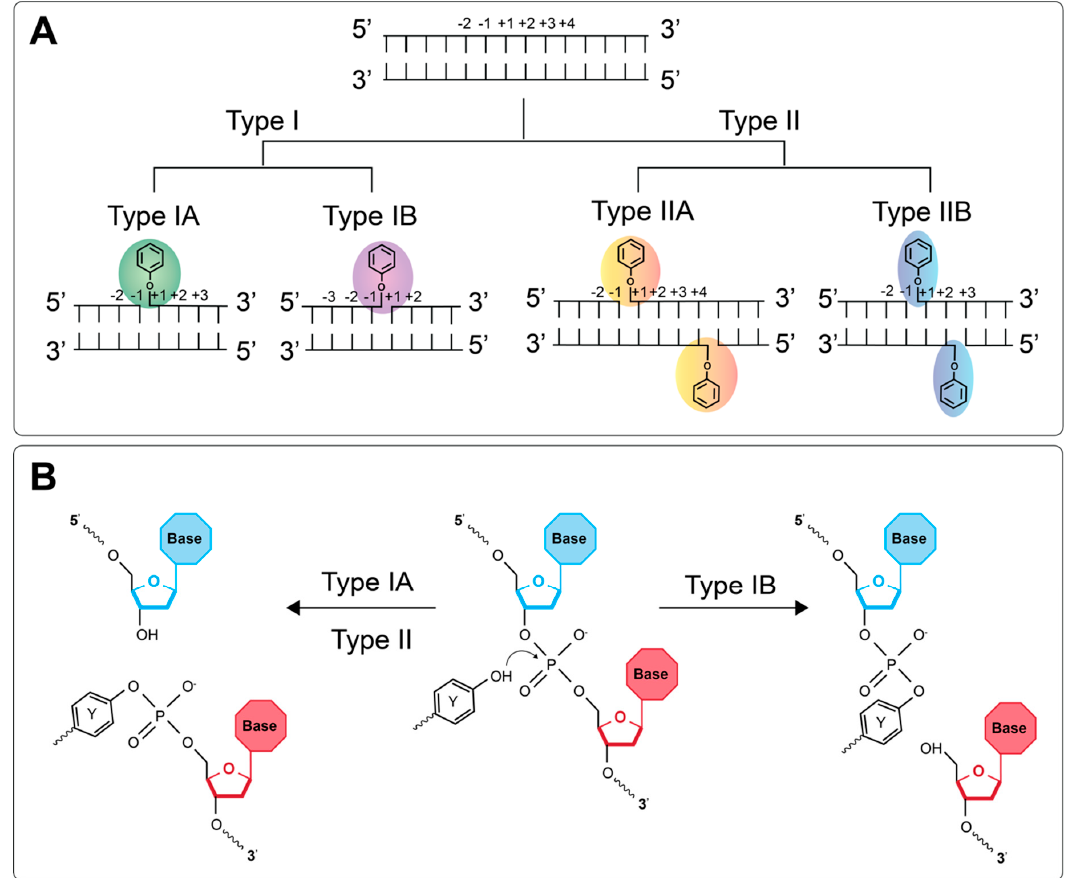
Figure 1. DNA cleavage by the DNA topoisomerases. ( A ) Representation of where the DNA is cleaved and the phophotyrosyl bond that is formed by each type of topo. ( B ) Chemistry of the covalent attachment between the active site tyrosine of the topo and the DNA backbone. For type IA and II topos, the 5 ′ phosphate group undergoes nucleophilic attack by the tyrosine OH group, whereas, for type IB, it is the 3 ′ phosphate group.